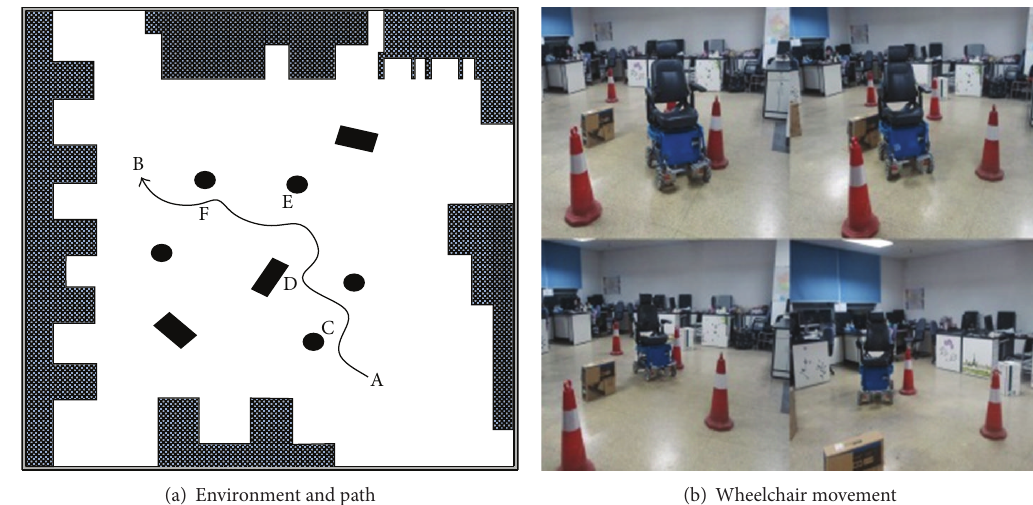
Figure 6: Experiment on